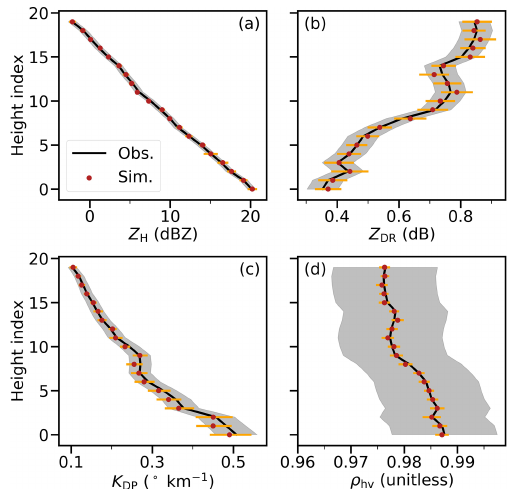
Figure 4. Profiles of (a) Z H , (b) Z DR , (c) K DP , and (d) ρ hv for syn- thetic observations (black line) calculated from the ice cloud proper- ties given in Fig. 5 and for the mean of forward simulations from the ensemble (red dots). Grey shading denotes the observational uncer- tainties given in Table 3, while error bars in orange denote retrieval uncertainty calculated as the 1-standard-deviation spread of the en- semble simulations.